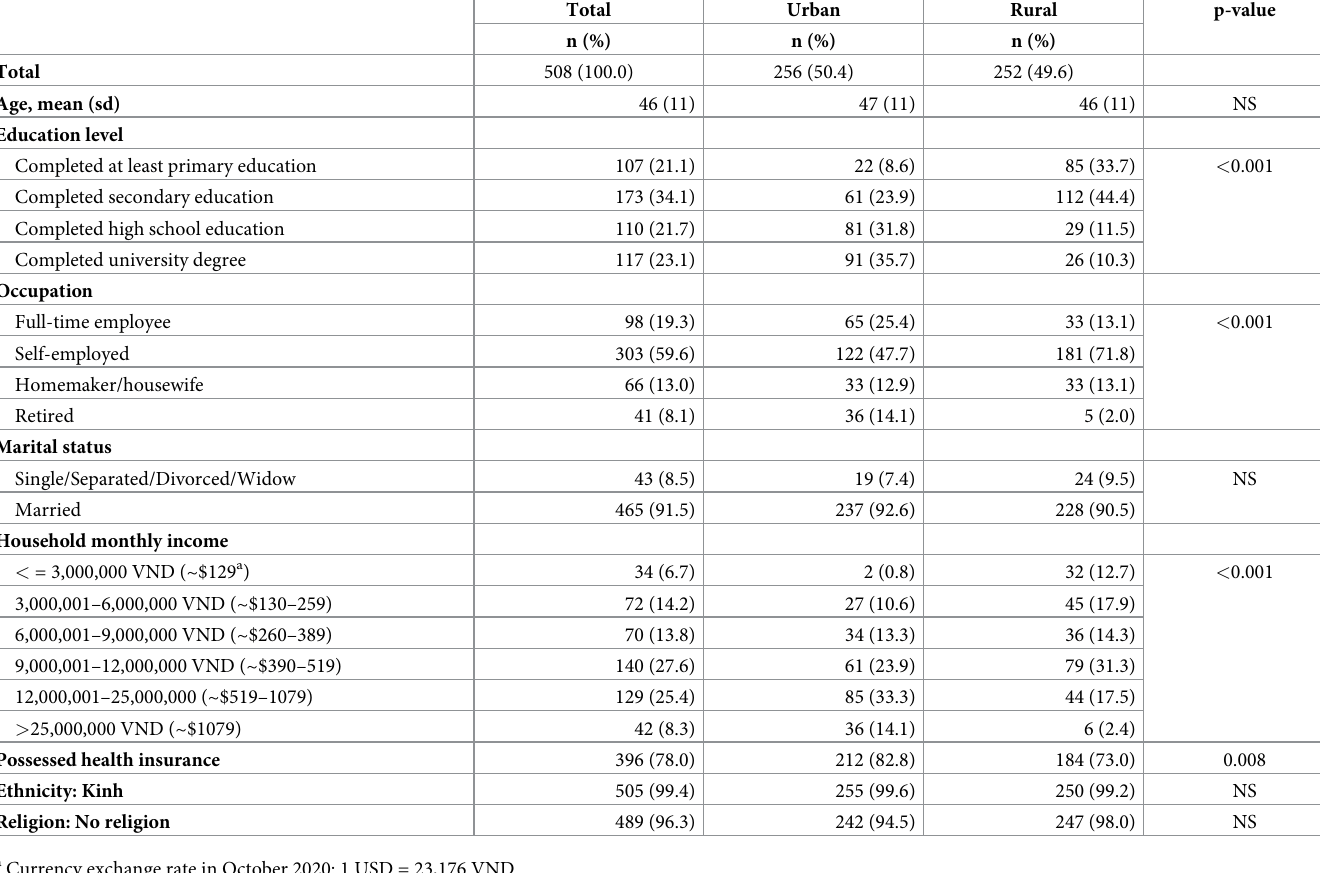
Table 1. Sociodemographic characteristics by area (urban vs